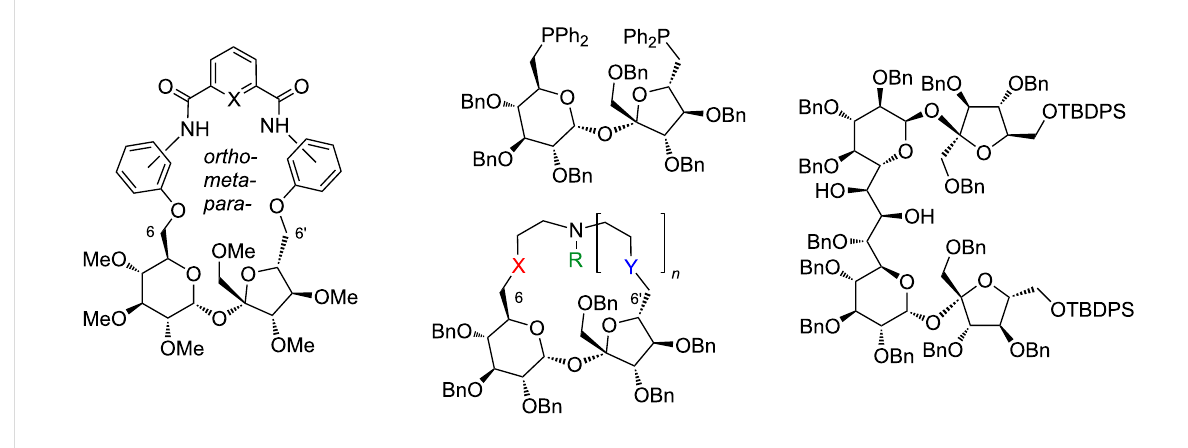
Figure 2: Examples of highly functionalized sucrose derivatives from our laboratory.